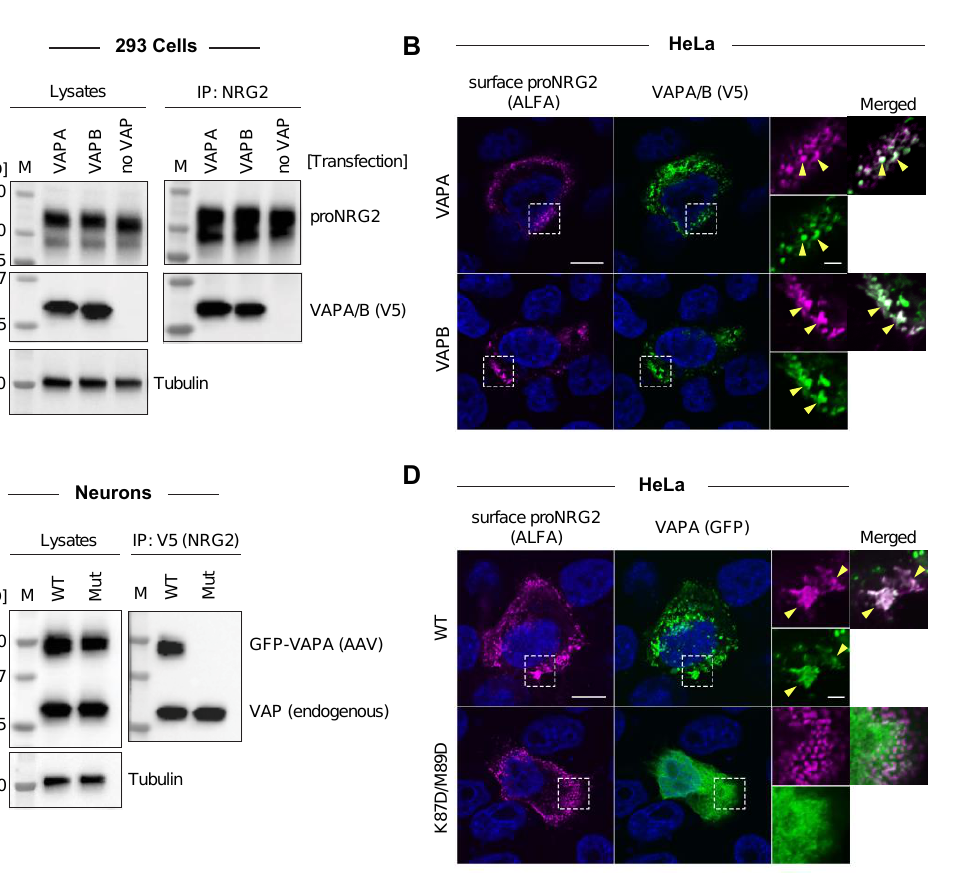
Figure 3. ProNRG2 interacts with VAPA and VAPB isoforms, and binding requires an intact FFAT binding site in VAP. ( A ), ProNRG2 co-immunoprecipitates both VAPA and VAPB in 293 cells trans- fected with untagged proNRG2 and V5-tagged VAPA/B, as indicated. Cells in the negative